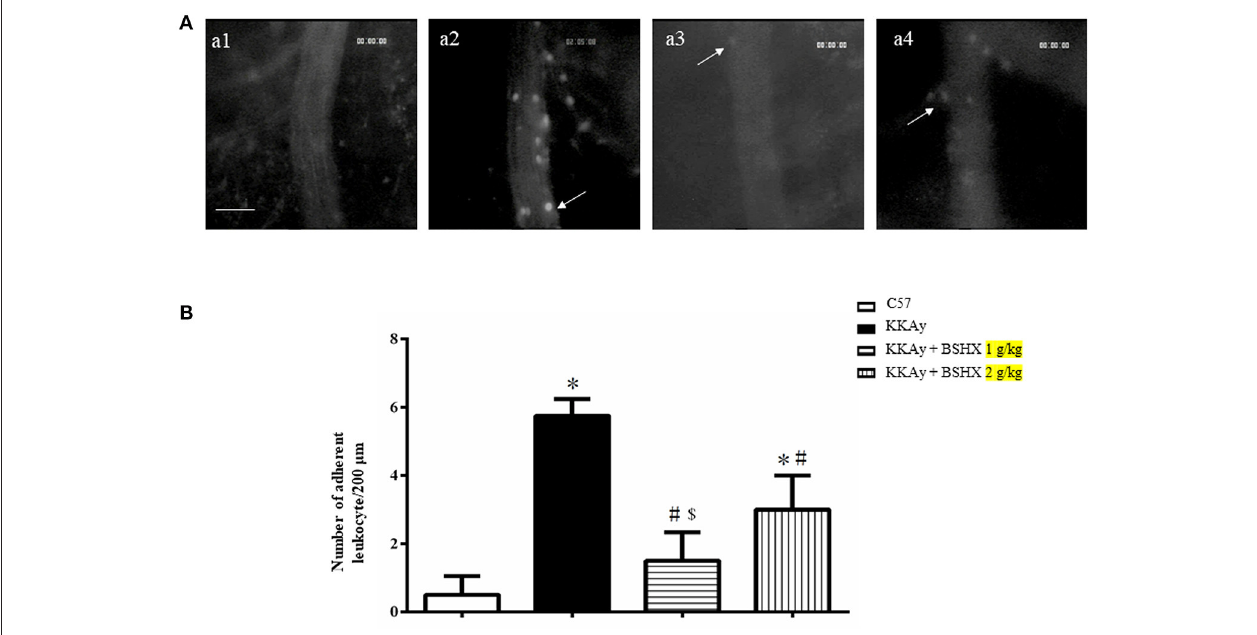
FIGURE 5 | The effect of BSHX on leukocyte adhesion in cerebral venules. (A) Representative pictures of leukocyte adhesion in various groups. Arrows indicate adherent leukocytes. a1: C57 group; a2: KKAy group; a3: KKAy + BSHX 1 g/kg group; a4: KKAy + BSHX 2 g/kg. Bar = 50 µ m. (B) Statistic analysis of the number of leukocytes adherent to venular wall. Data were expressed as mean ± SD ( n = 6). * p < 0.05 vs. C57 group, # p < 0.05 vs. KKAy group, $ p < 0.05 vs. KKAy + BSHX 2 g/kg group.